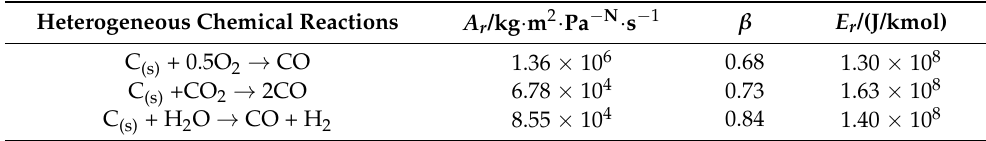
Table 3. Kinetic parameters of heterogeneous chemical reactions.